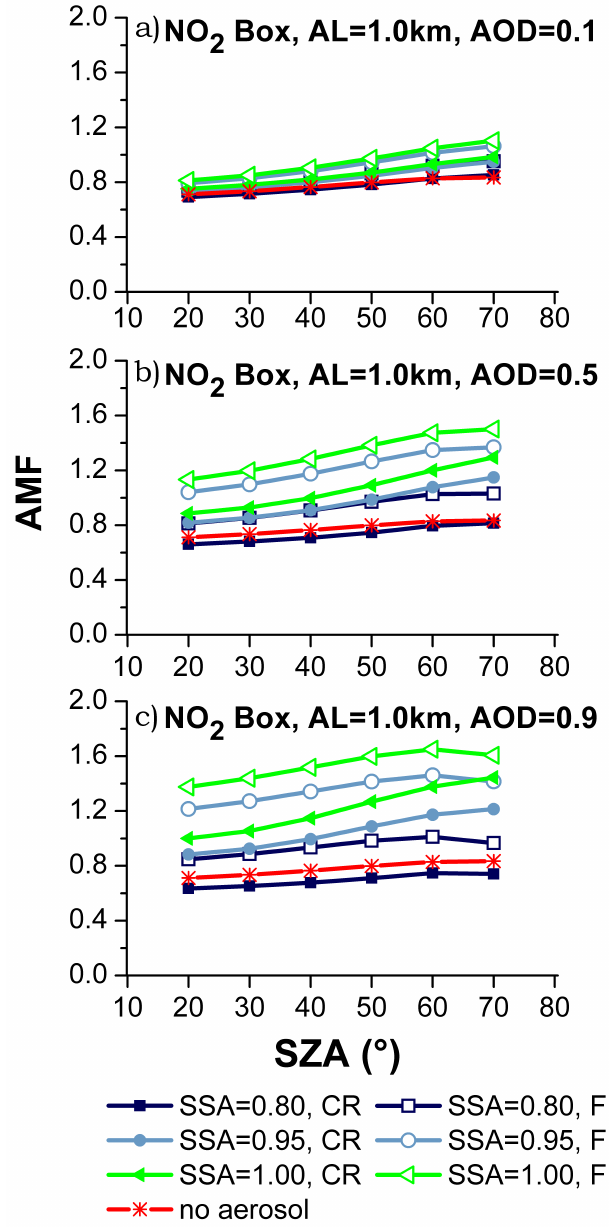
Fig. 11. NO 2 airmass factors for simulations with different single scattering albedo (SSA, ω 0 = 0.80, 0.95 and 1.00) for scenario C (NO 2 and aerosol layer (AL) – 1.0km box profile), calculated with the phase functions determined for coarse (CR) and fine (F) par- ticles (optical properties taken from Creteil/Paris AERONET sta- tion). AMFs determined at 440 nm, with surface albedo = 0.03, and different AODs: (a) 0.1, (b) 0.5 and (c)